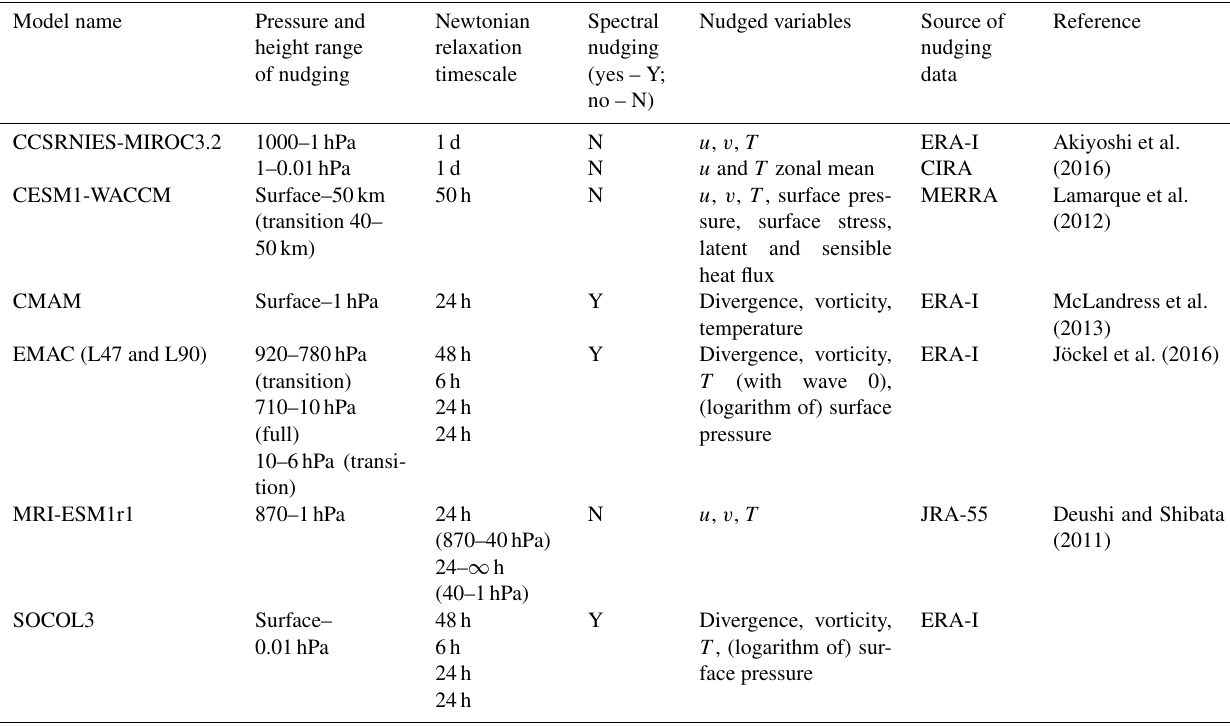
Table 2. Details of nudging in the CCMI REF-C1SD simulations that provided TEM diagnostics model output used in this study. ERA-I is ERA-Interim, CIRA is Cooperative Institute for Research in the Atmosphere, MERRA is Modern-Era Retrospective reanalysis, and JRA-55 is Japanese 55-year Reanalysis. T (with wave 0) for EMAC refers to the additional nudging of the global mean